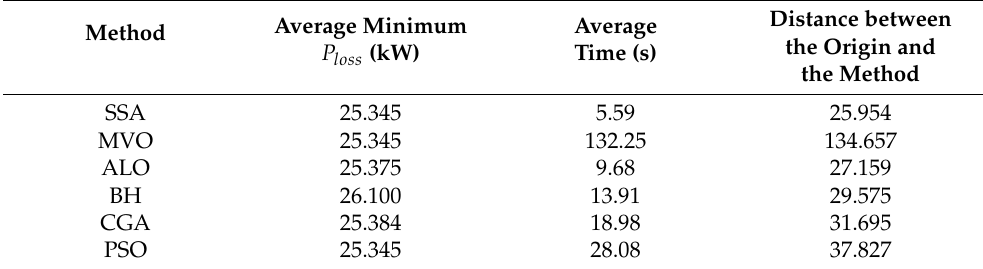
Figure 10. Percentage of reduction in average power losses obtained by the SSA in the 69-node system compared to that of the other methodologies. Table 8. Average minimum power losses vs. average time in the 69-node